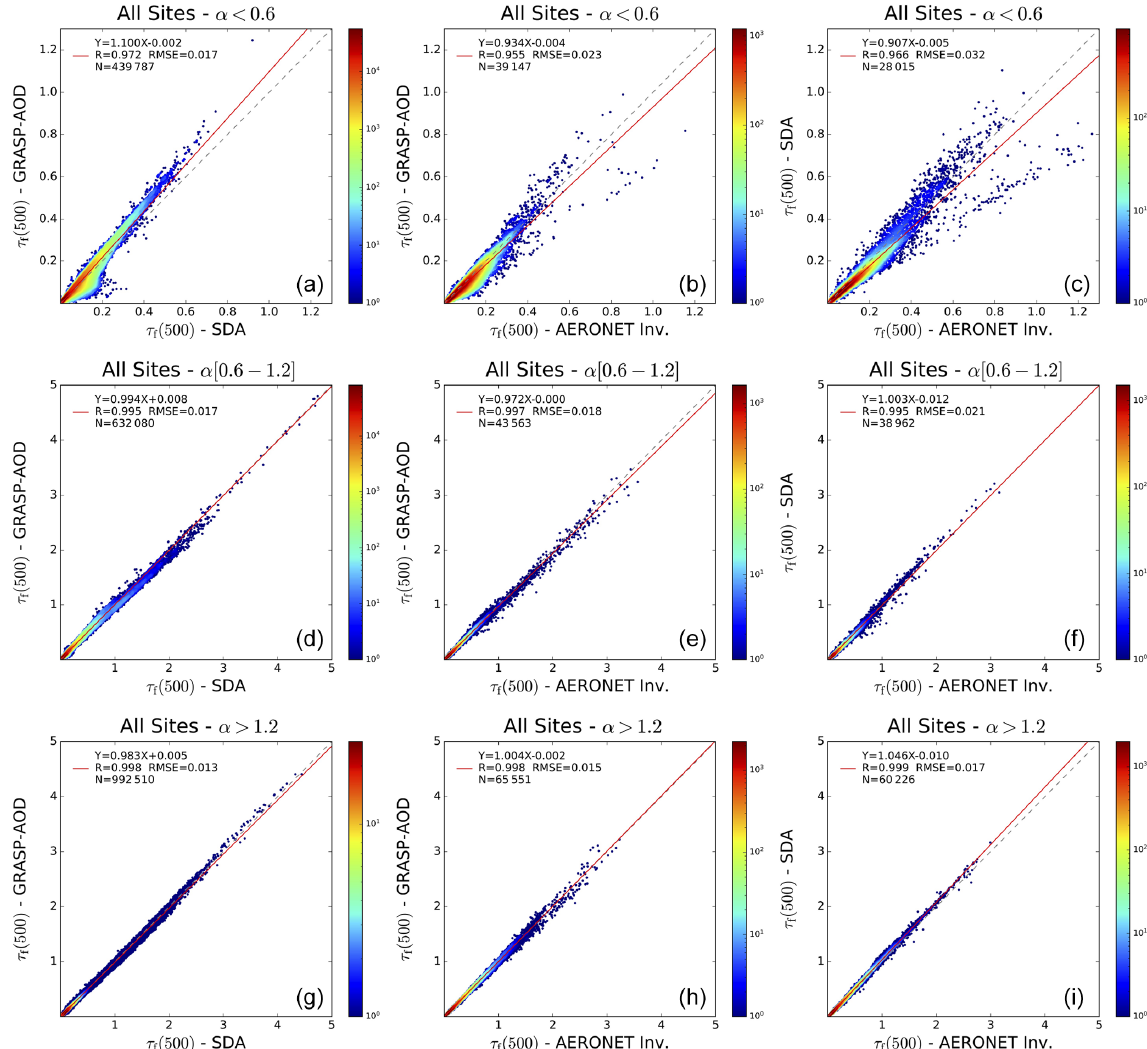
Figure 5. Comparisons of τ f ( 500 ) retrieved from all sites for different ranges of the Ångström exponent values: α < 0 . 6 (a) – (c) , α between 0.6 and 1.2 (d) – (f) and α > 1 . 2 (g) – (i) . From left to right the comparisons are made between the SDA and GRASP-AOD, AERONET aerosol retrieval algorithm and GRASP-AOD, and AERONET aerosol retrieval algorithm and SDA. Color bars represent data density in a 0 . 01 × 0 . 01